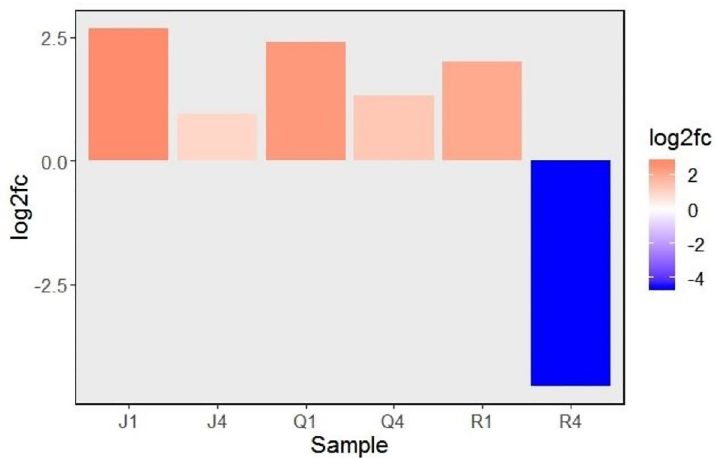
Fig 2. Relative expression (log2 fold change) of triterpene saponin biosynthesis activating regulator-like1 (TSARL1) gene at 1 and 4 days after inoculation with cucumber mosaic virus. The red and blue colors indicates up and down regulation patterns, respectively. Abbreviations are combinations of cultivars (J,Q, or R) and days-post- inoculation (1 or 4). Varieiteis tested were: Jessie (J), QQ74 (Q), and Red Head (R).